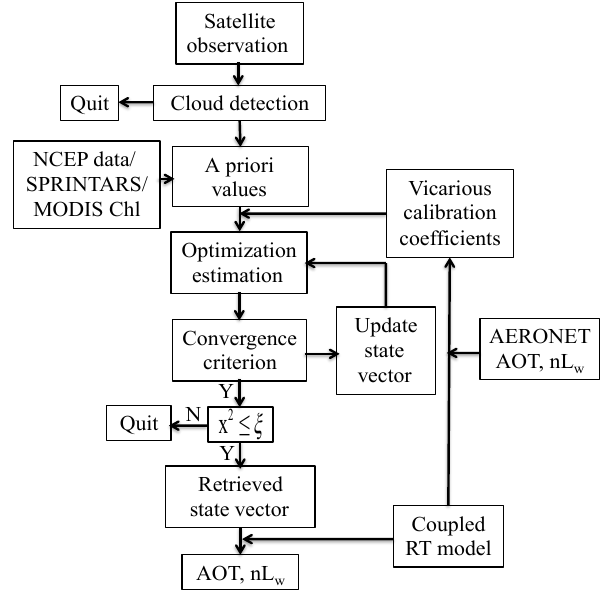
Figure 1. Flow chart of the retrieval